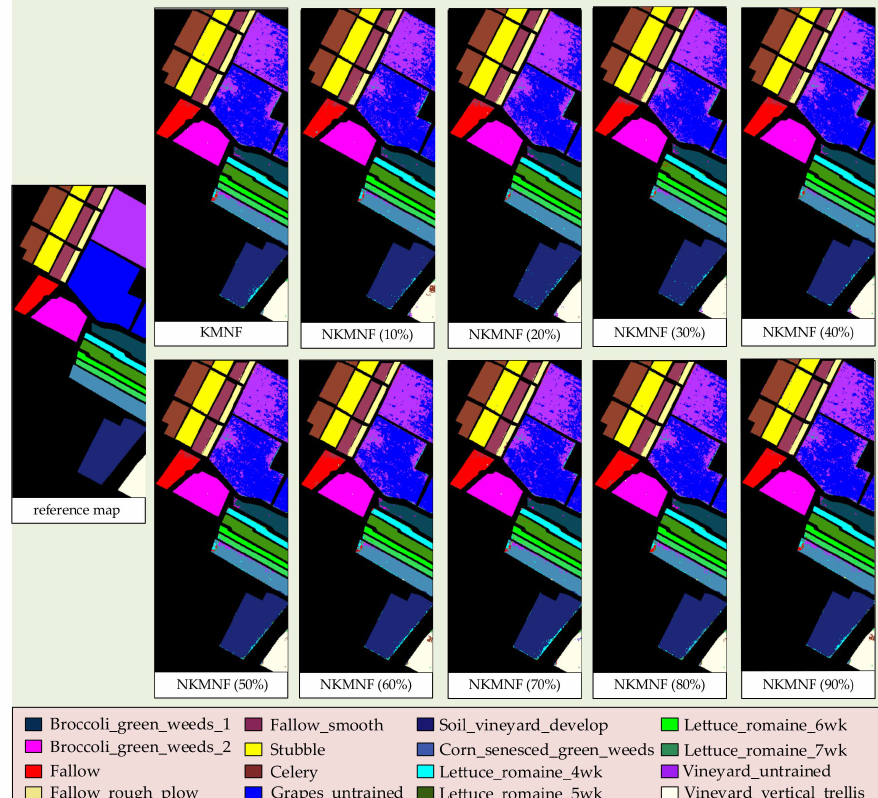
Figure 15. The results of SVM classifier for Salinas after NKMNF with different proportion sample sizes (number of features = 45).